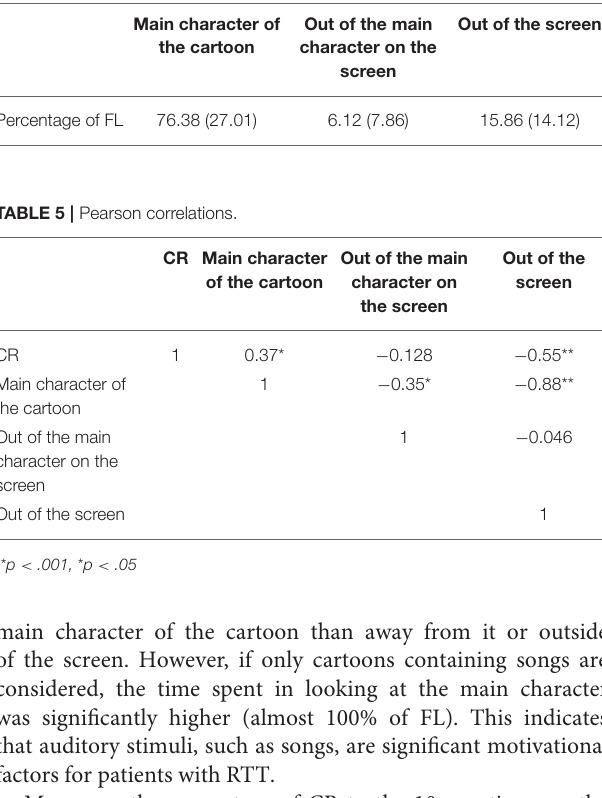
TABLE 4 | Means and (Standard deviations) of percentage of fixation length for the cartoon.